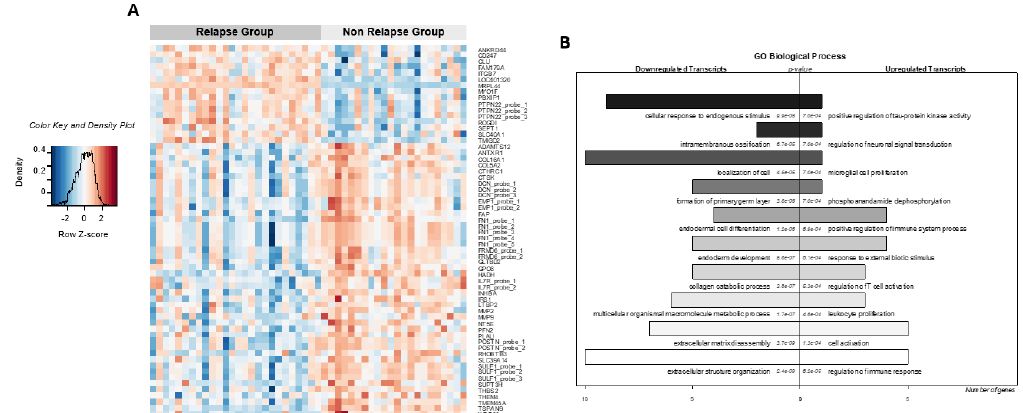
Figure 2. Molecular signature associated with clinical outcome and Gene Ontology Biological Process enrichment. ( A ) Heatmap of microarray data showing the 47 deregulated genes in “relapsing” ( n = 26, dark grey) compared to “non- relapsing” samples ( n = 22, light grey). Each column represents a sample, and each row a probe set or gene. The expression level of each probe set was standardized by subtracting that probe set’s mean expression from its expression value and then dividing this by the standard deviation across all the samples. This scaled expression value, designated as the row Z-score, was plotted using a red–blue color scale with red indicating high expression and blue indicating low expression. ( B ) Enrichment of these deregulated genes within the Gene Ontology (GO) categories with the 10 most-listed GO biological processes categories ( p < 0.01). The number of probe sets downregulated or upregulated in “relapsing” specimens is represented below. The p -values of each GO category are reported on the graph.